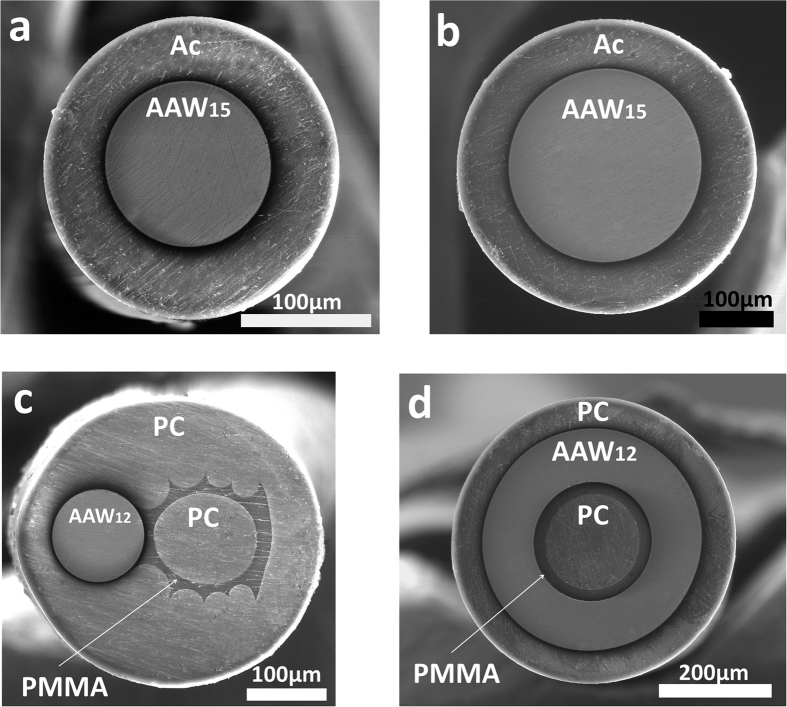
Cross-section SEM images of: (a,b) 125 μm and 250 μm diameter single-core AAW15 glass fibers with acrylic coating (Ac); (c) two circular-core fiber with 125 μm diameter AAW12 glass and 140 μm diameter PC cores and (d) ring-core fiber with a PC cladding ring of 45 μm thickness, an electrically conductive AAW12 glass ring of 90 μm thickness, a PMMA ring of 25 μm thickness, and a PC core of 155 μm diameter. Glass labels: AAW12: 45AgI-43-AgPO3-12WO3, AAW15: 45AgI-40-AgPO3-15WO3.